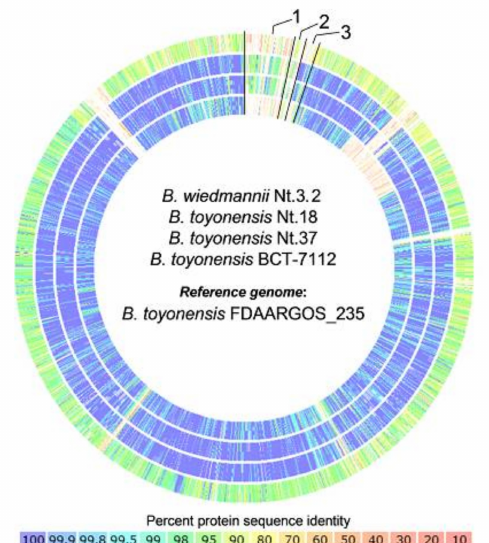
Figure 3. Protein sequence-based comparison of genome data of B. toyonensis isolates Nt.18 and Nt.37, strain BCT-7112 used as a B. toyonensis species representative and an isolate of the closely related species B. wiedmannii , Nt.3.2, with reference genome of strain FDAARGOS_235 (not shown). Numbers indicate segments corresponding to three plasmids identified in the reference genome. The color represents the percentage of sequence